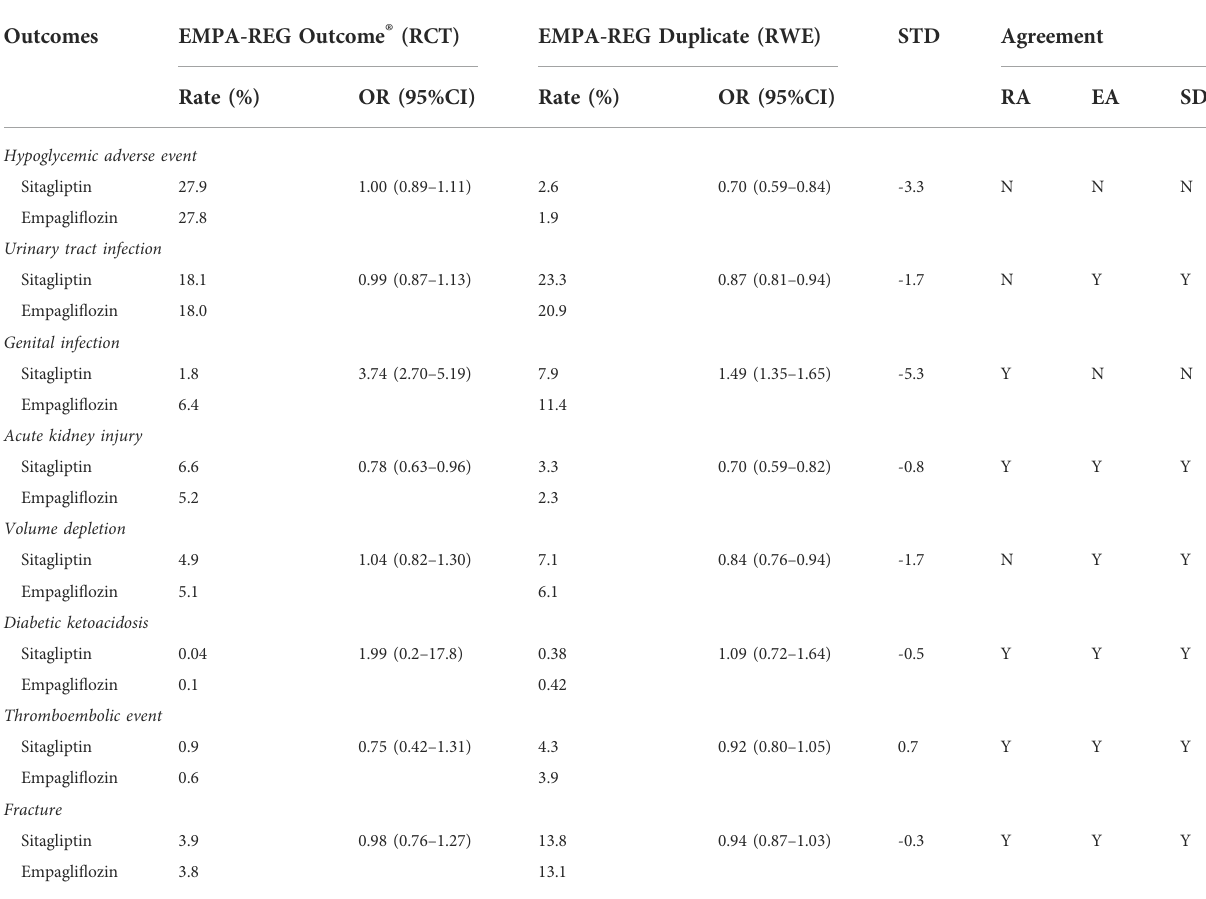
TABLE 4 RCT-RWE agreement for each safety